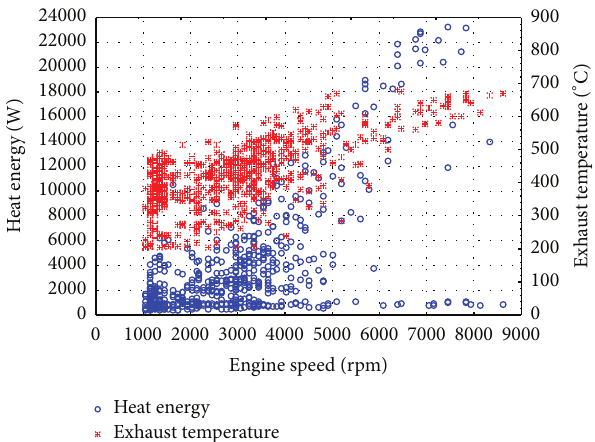
Figure 3: Heat energy from exhaust gas of experimental vehicle on engine speed and exhaust temperature.